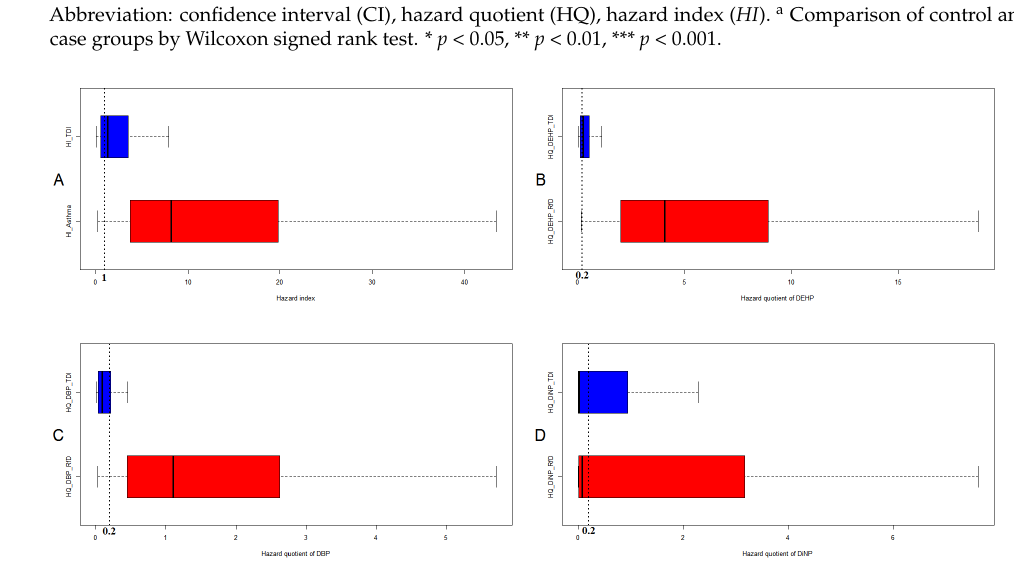
Table 6. Hazard quotients and hazard index by reference dose for control and case groups.